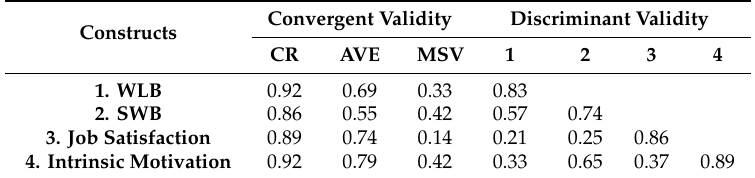
Table 5. Overall Reliability and Validity of the